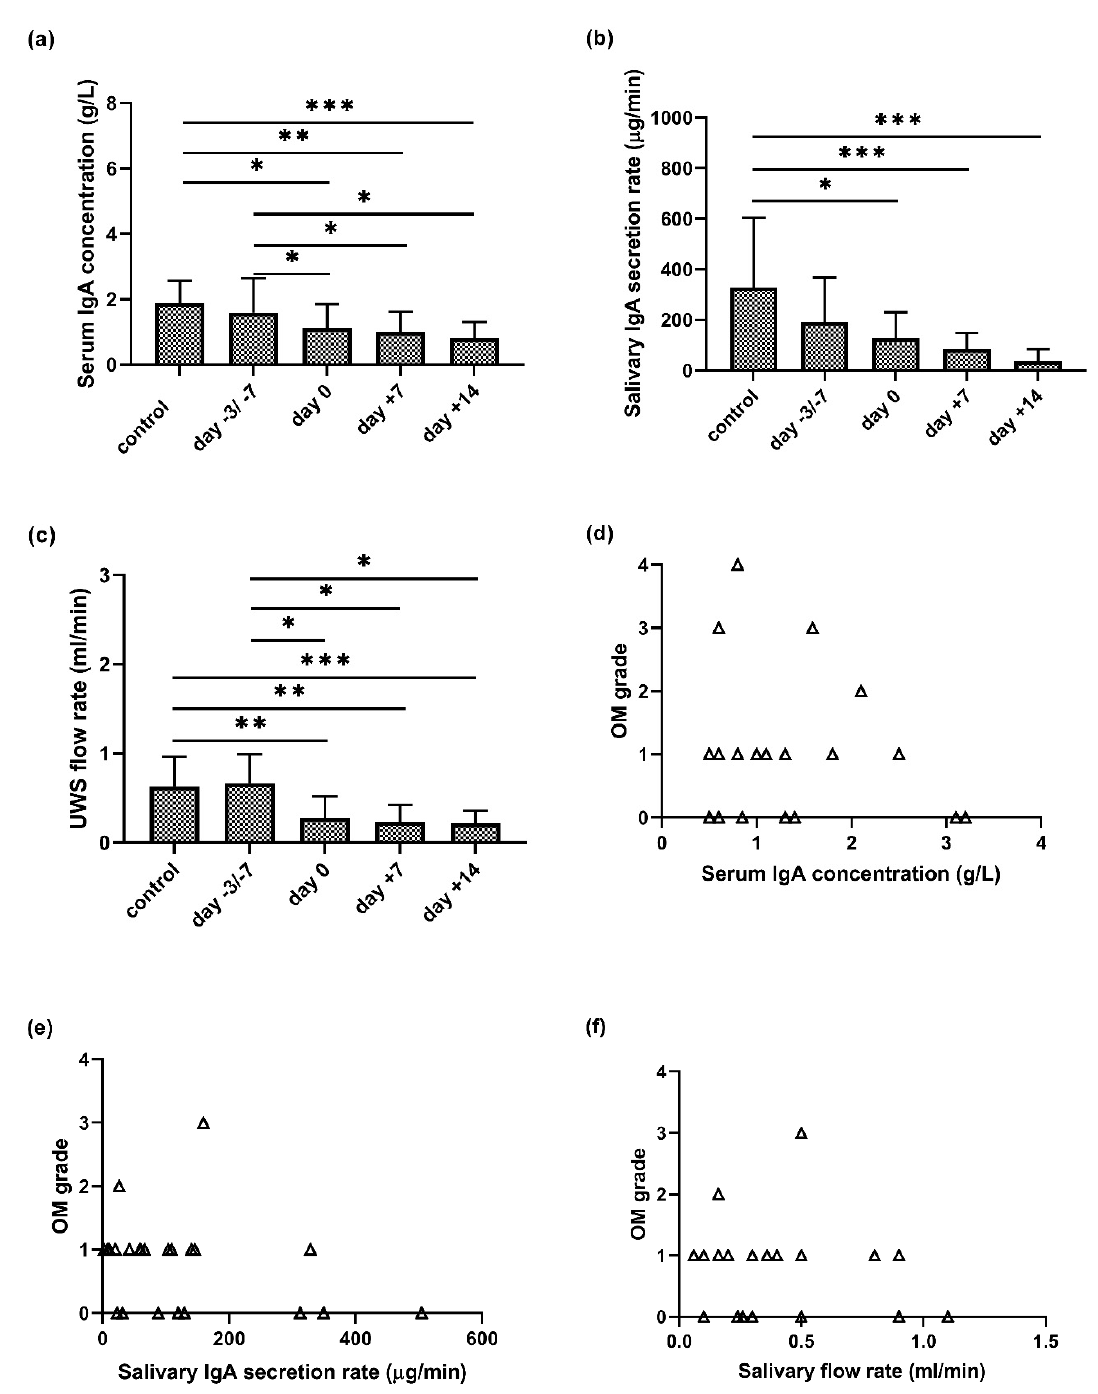
Figure 2. Serum IgA concentration ( a ), salivary IgA secretion rate ( b ), salivary flow rate ( c ) of unstimulated whole saliva (UWS) in the control and patient group at four stages of autologous peripheral stem cell transplantation (APSCT) and its correlation ( d – f ) with severity of oral mucositis (OM). In ( a–c ), the values are expressed as sample means; error bars represent the estimates of standard deviations calculated from three parallel measurements (* p ˂ 0.05, ** p ˂ 0.01, *** p ˂ 0.001).